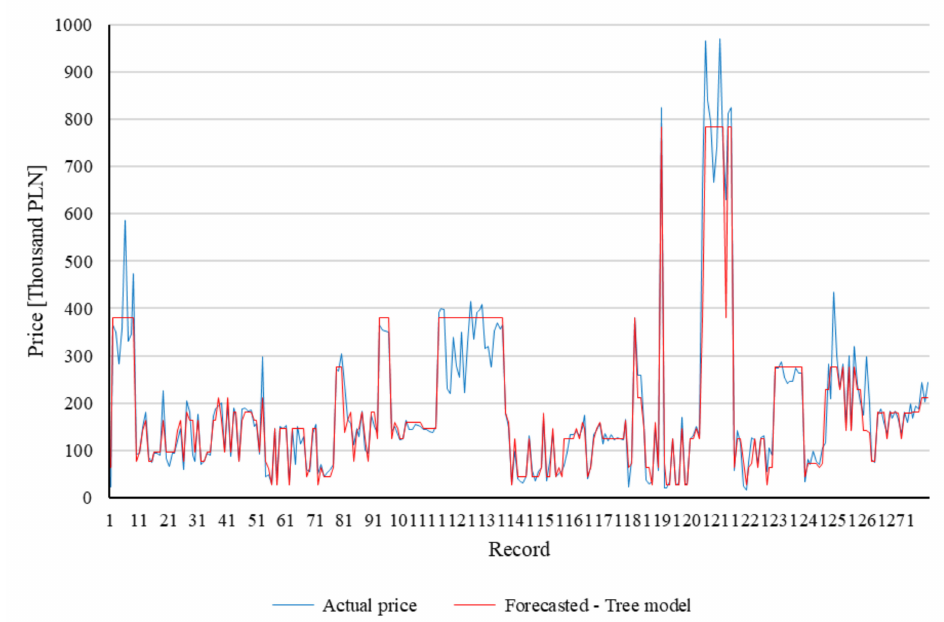
Figure 5. Results of forecasting the price of electric cars using decision tree